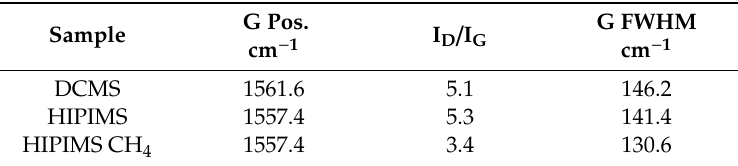
Table 2. Raman analysis of the